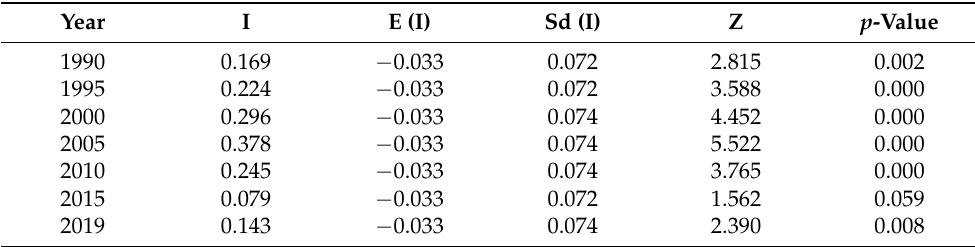
Table 5. Global Moran index of coupling coordination degree of China’s industrialization and agricultural green development in some years.